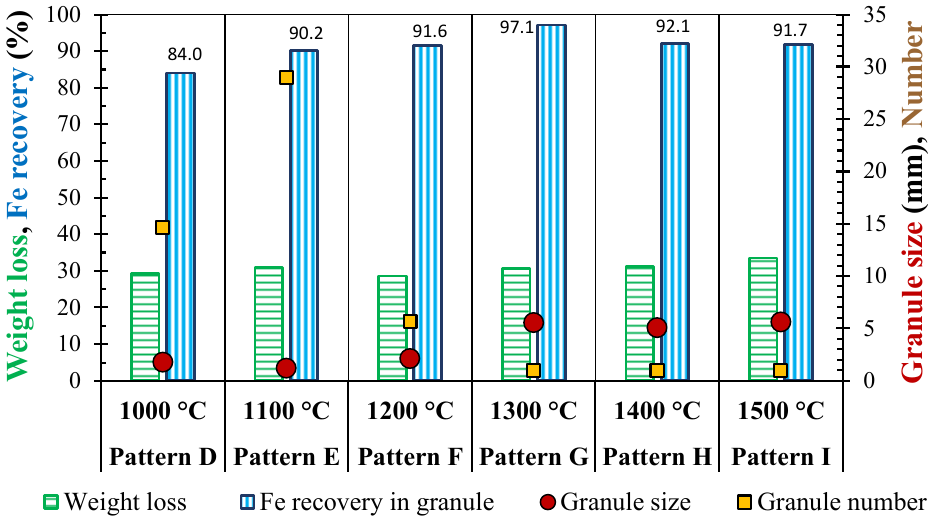
Figure 7. Effect of initial temperature on weight loss, iron recovery in granules, granule diameter, and number of granules from the carbothermic reduction of the ilmenite concentrate at 30% Na 2 CO 3 addition, different initial temperatures, and final temperatures of 1500 ◦ C.